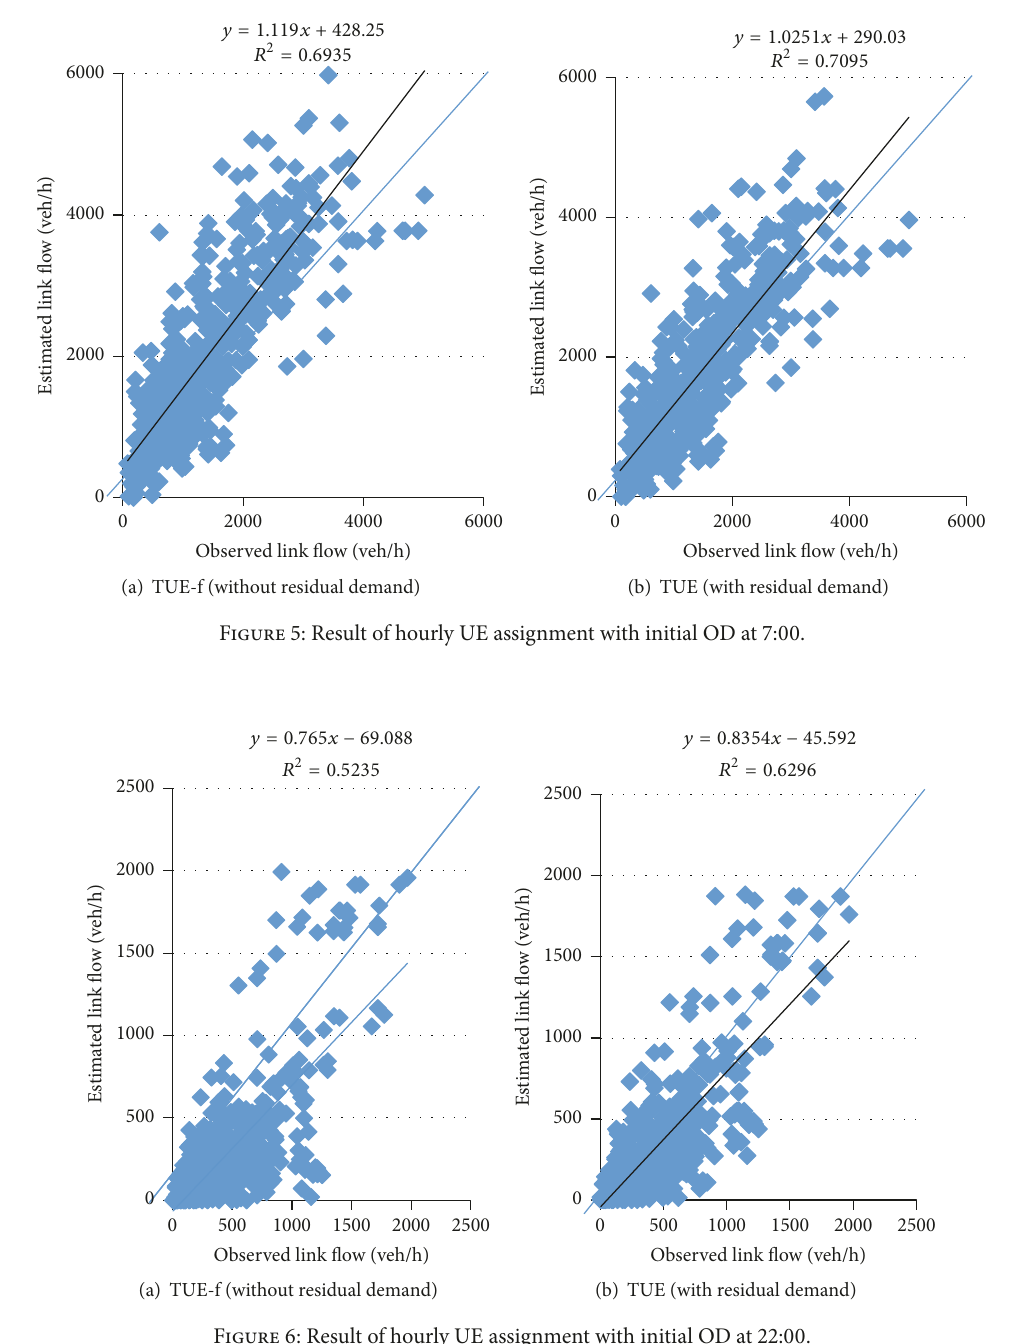
Figure 6: Result of hourly UE assignment with initial OD at